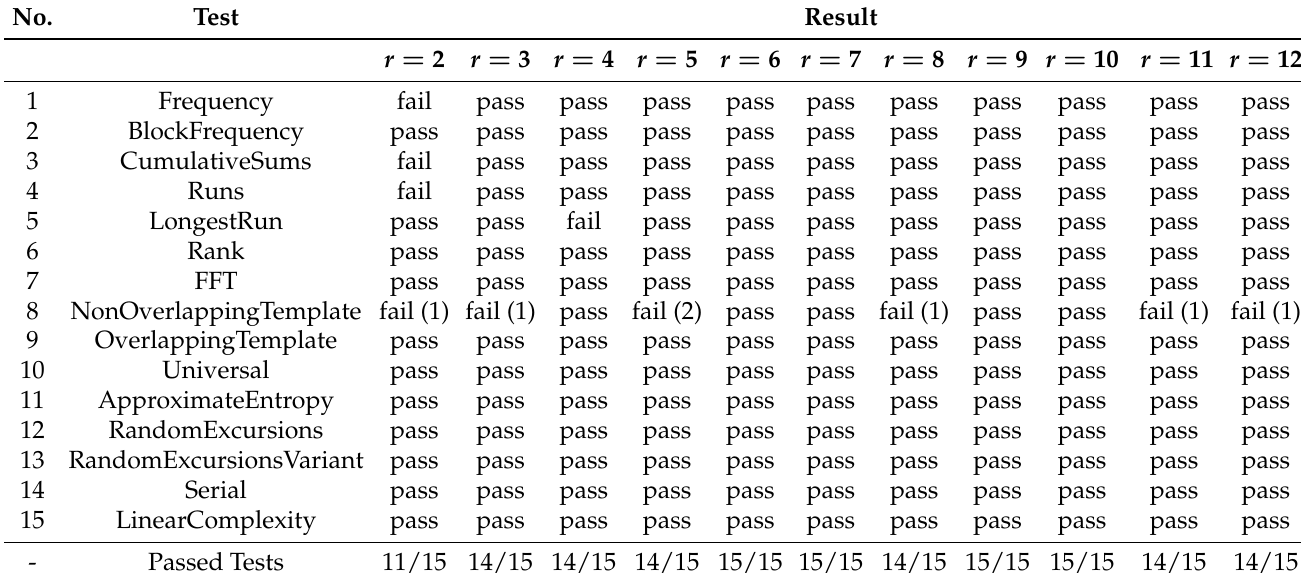
Table A4. NIST test results for (33) using map (27) ( x 0 = 0.1, k = 10, a =